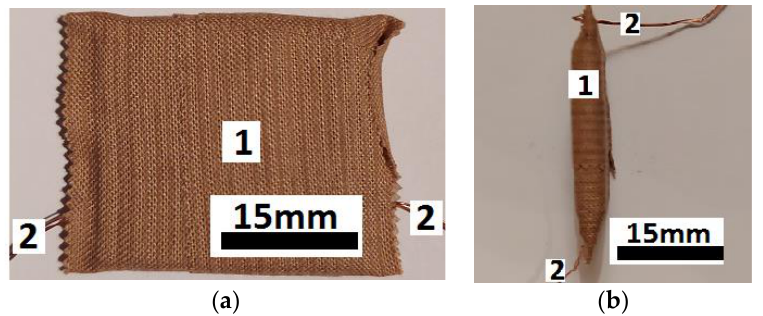
Figure 4. ( a ) Electrical device ED: Top-view. ( b ) Electrical device ED: Cross-sectional view. 1 — PTS tape, 2 — copper conductors. tape, 2—copper conductors.